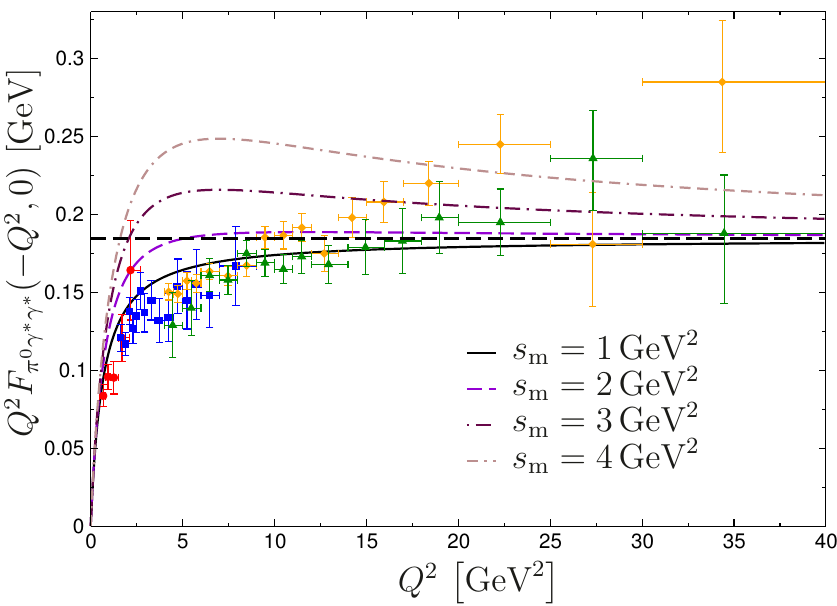
Figure 16. Comparison of (E.9) to singly-virtual pion TFF data [163{166]. Color coding for the experimental points as in (cid:12)gure